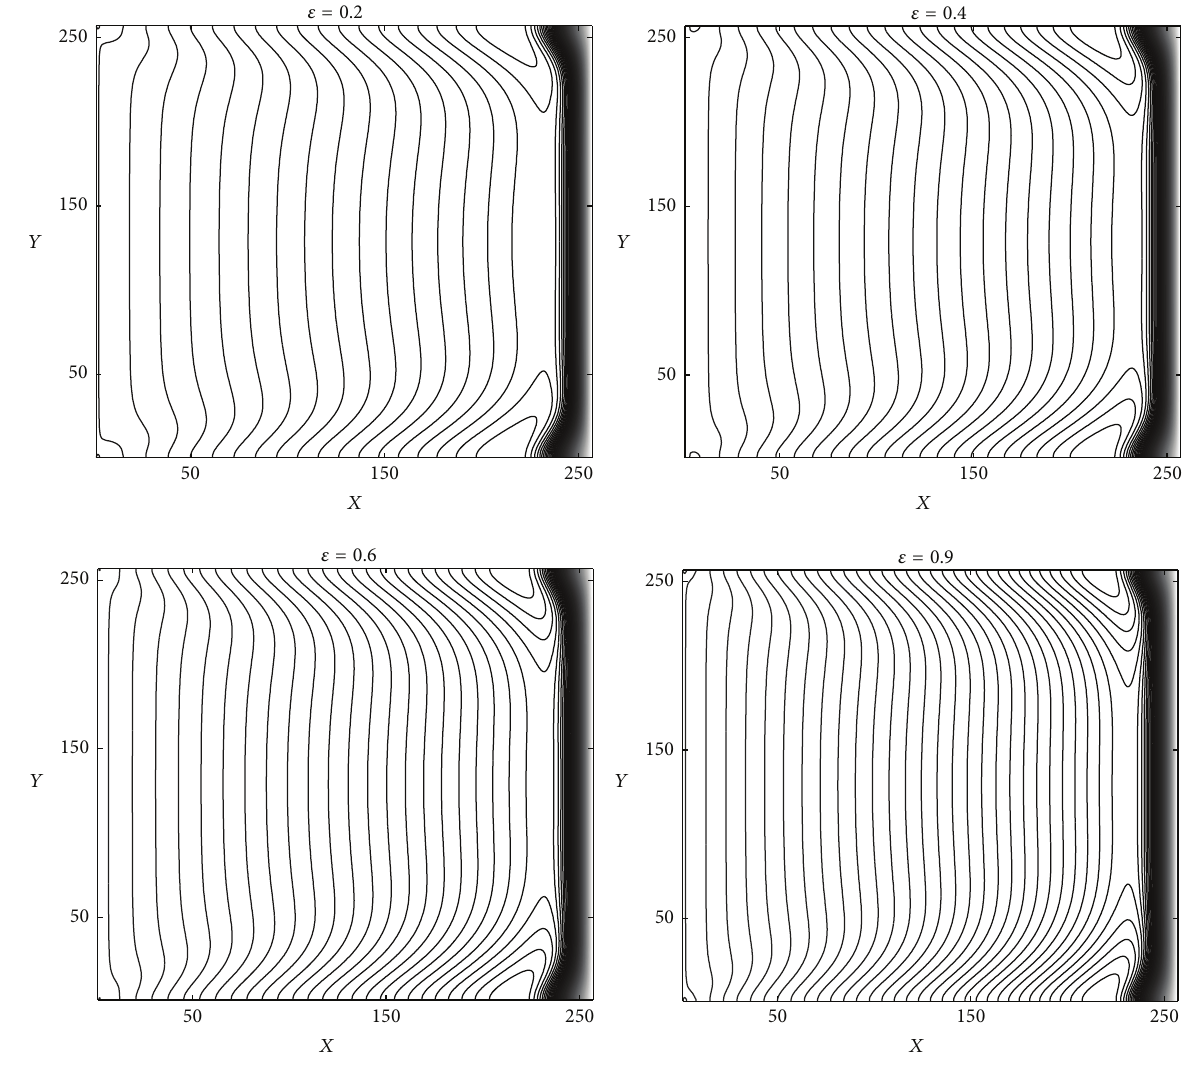
Figure 2: The isothermals for porosity: 𝜀 = 0.2, 0.4, 0.6,